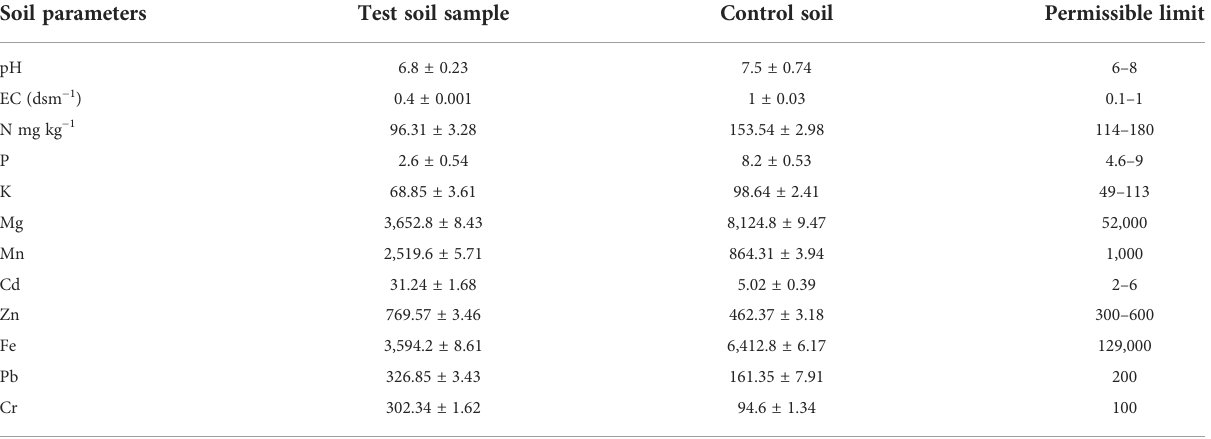
TABLE 1 Physicochemical properties of test soil sample compared with control soil. Soil